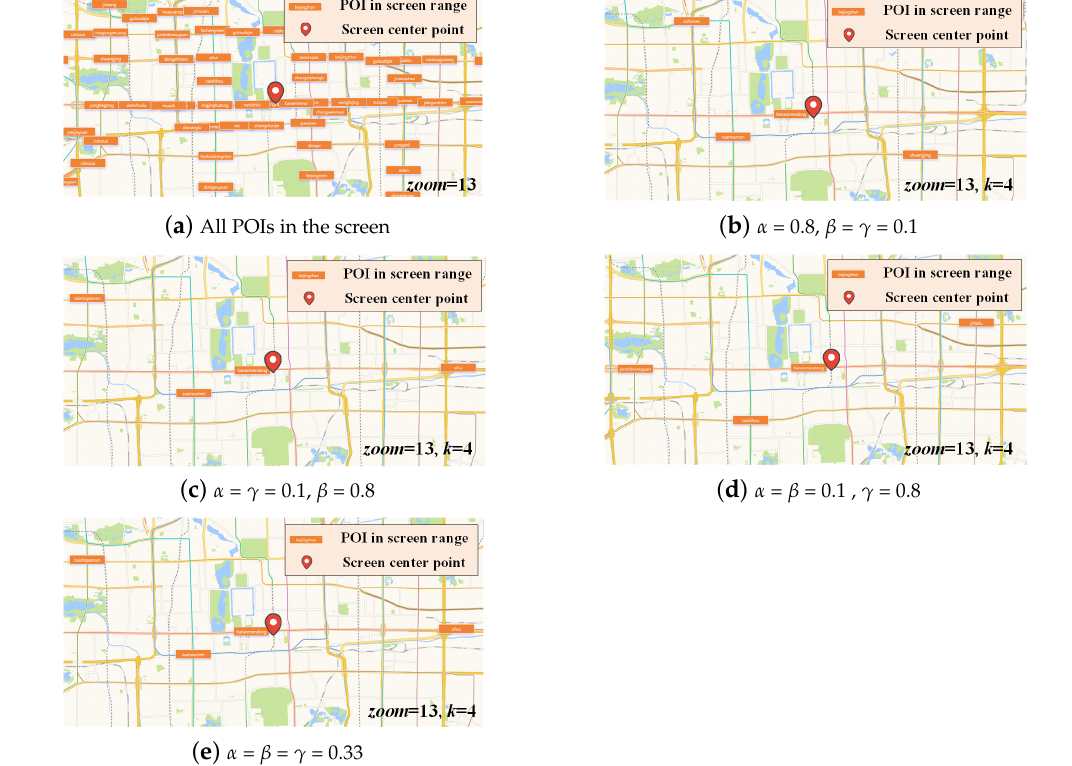
Figure 12. Selection results under different α , β and γ values.